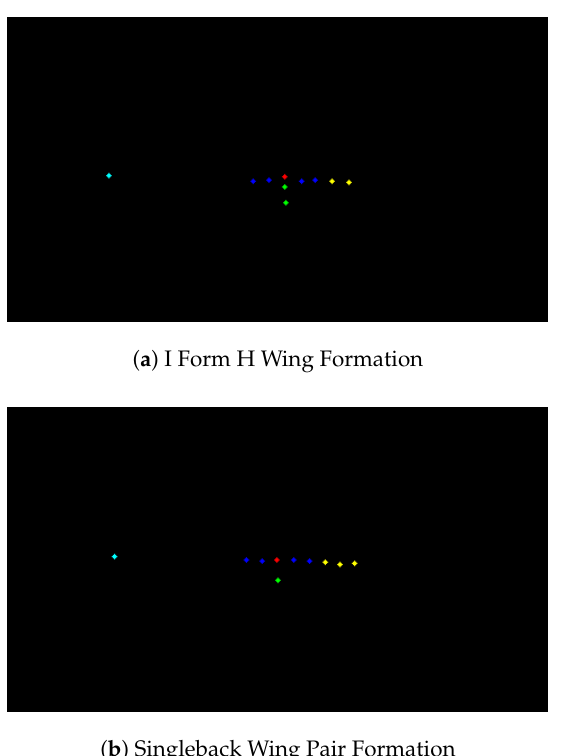
Figure 11. Player count modification example—players are randomly added or removed from the data.